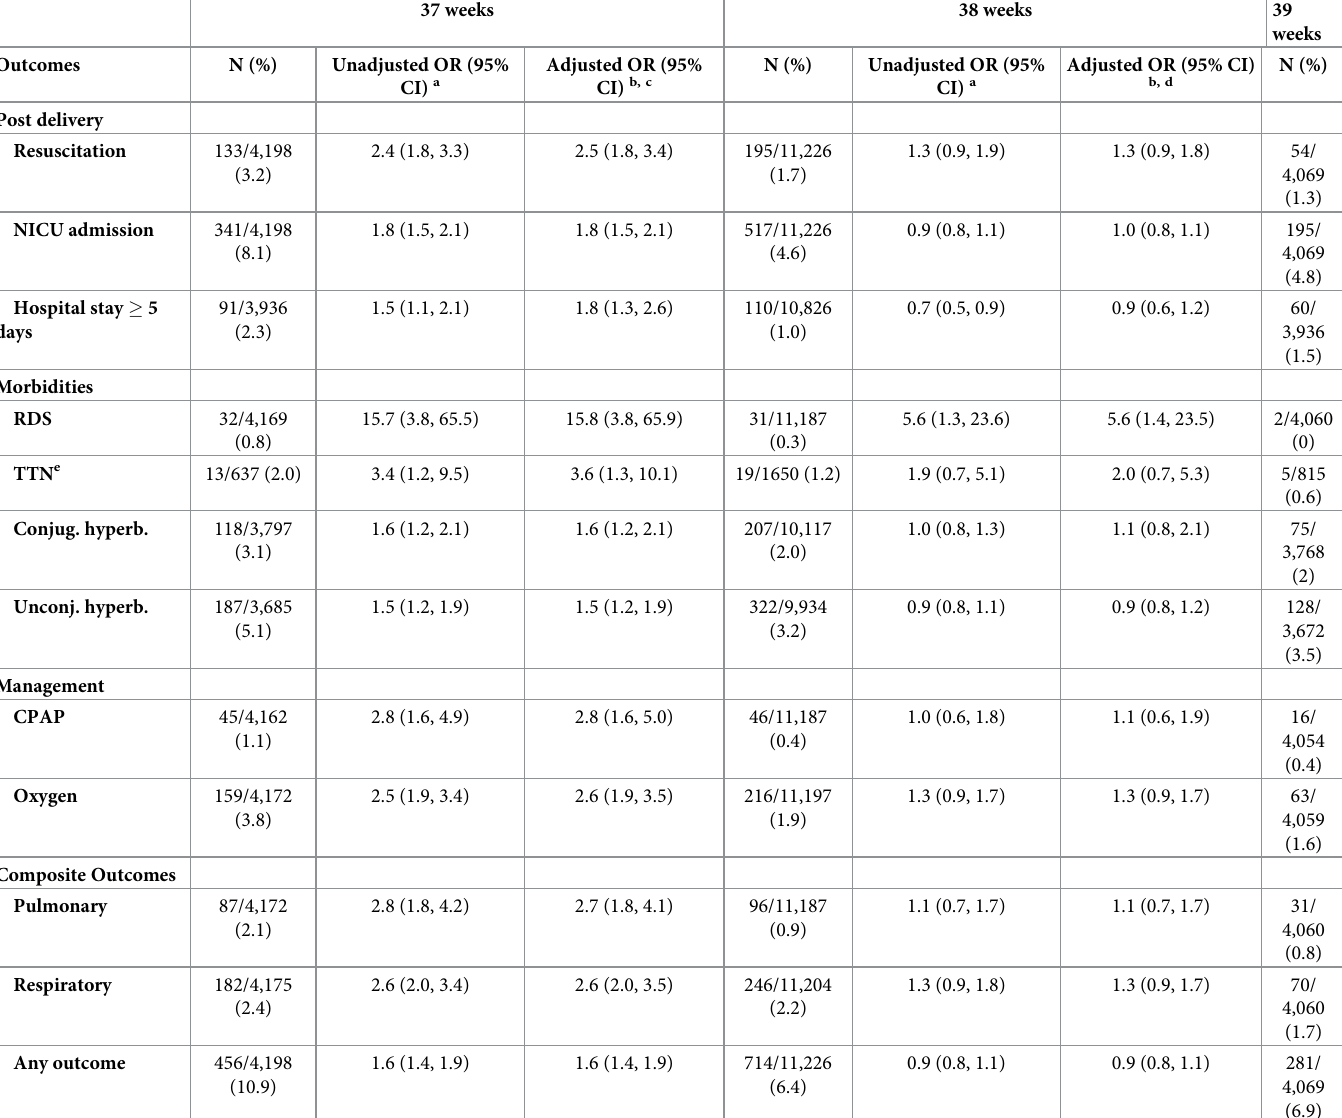
Table 3. Unadjusted and adjusted ORs for adverse neonatal outcomes at 37 and 38 compared to 39 weeks of gestation among women with repeat